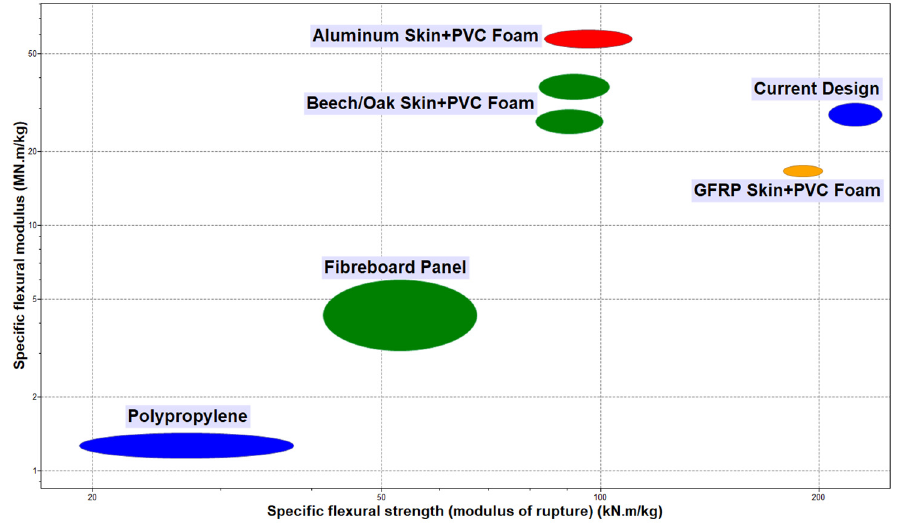
Figure 8. Specific flexural modulus versus specific flexural strength to compare currently used truck panel materials with current sustainable design (source: CES EduPack software).